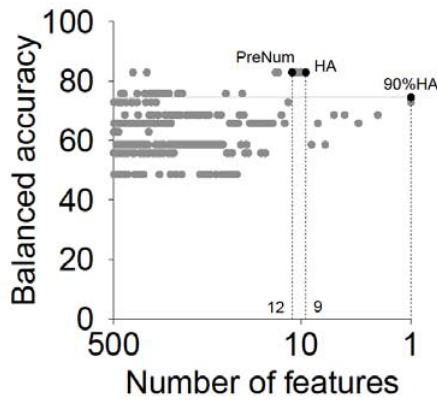
Figure 3. The three variants we analyzed in this study: HA, 90% HA, and PreNum (equals to 12). The result was analyzed based on the TG-Gates_500 data.